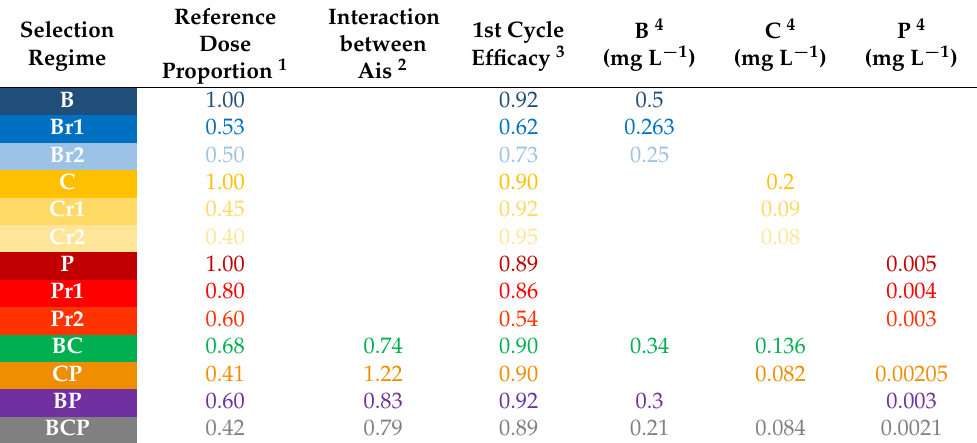
Table 1. Doses of fungicides B, C and P and of their mixtures used to select resistance in the various experimental evolution